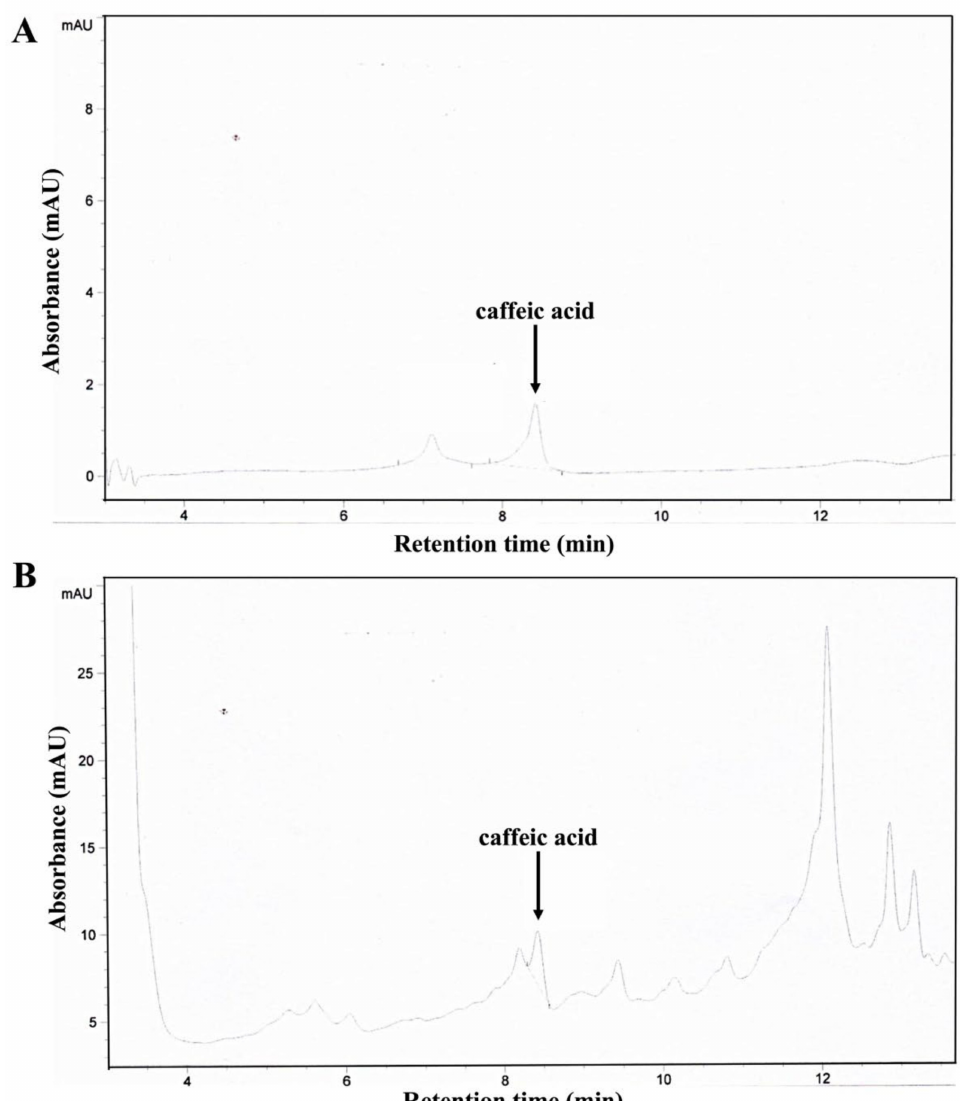
Figure 1. HPLC chromograms of ( A ) caffeic acid standard (R t = 8.420 min) and ( B ) CF-EE extract chromatographic condition; Zorbax Eclipse XDB-C18 column (4.6 × 150 mm, 5 micro). Mobile phase: 2% acetic acid–water (gradient) at a flow rate of 0.6 mL/min; UV detection wavelength: 327